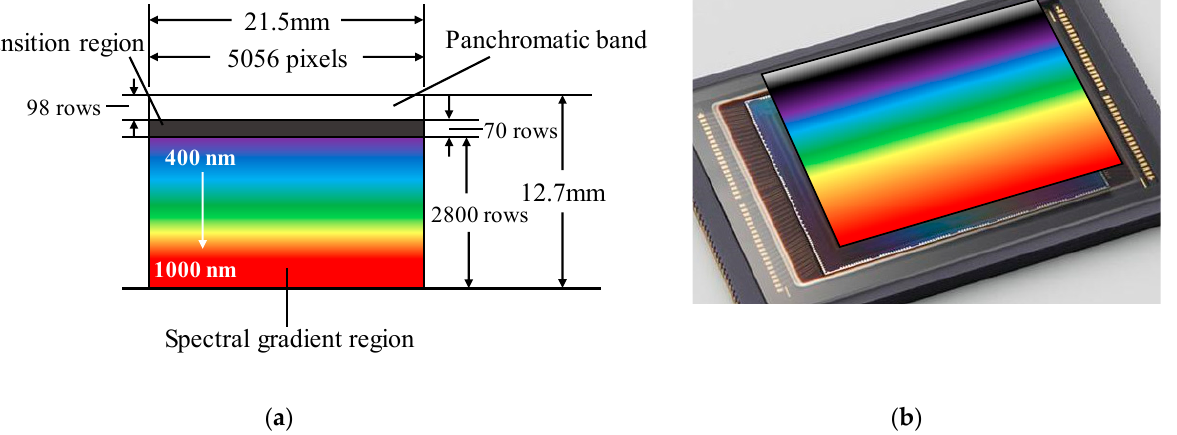
Figure 3. ( a ) The corresponding relationship between filter and detector. ( b ) schematic of the structure.